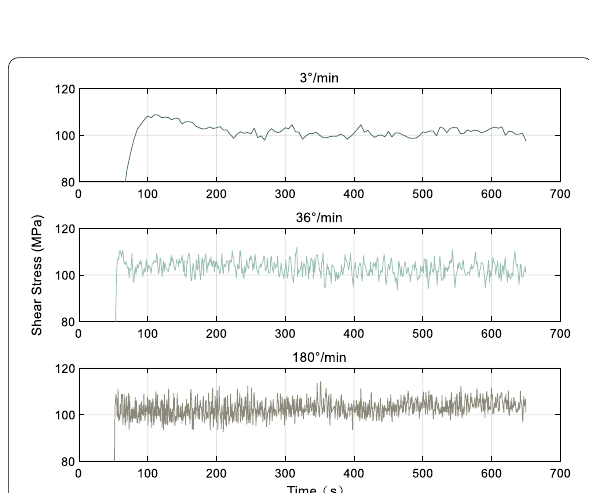
Fig. 3 Relationship between time and the shear stress for different shear